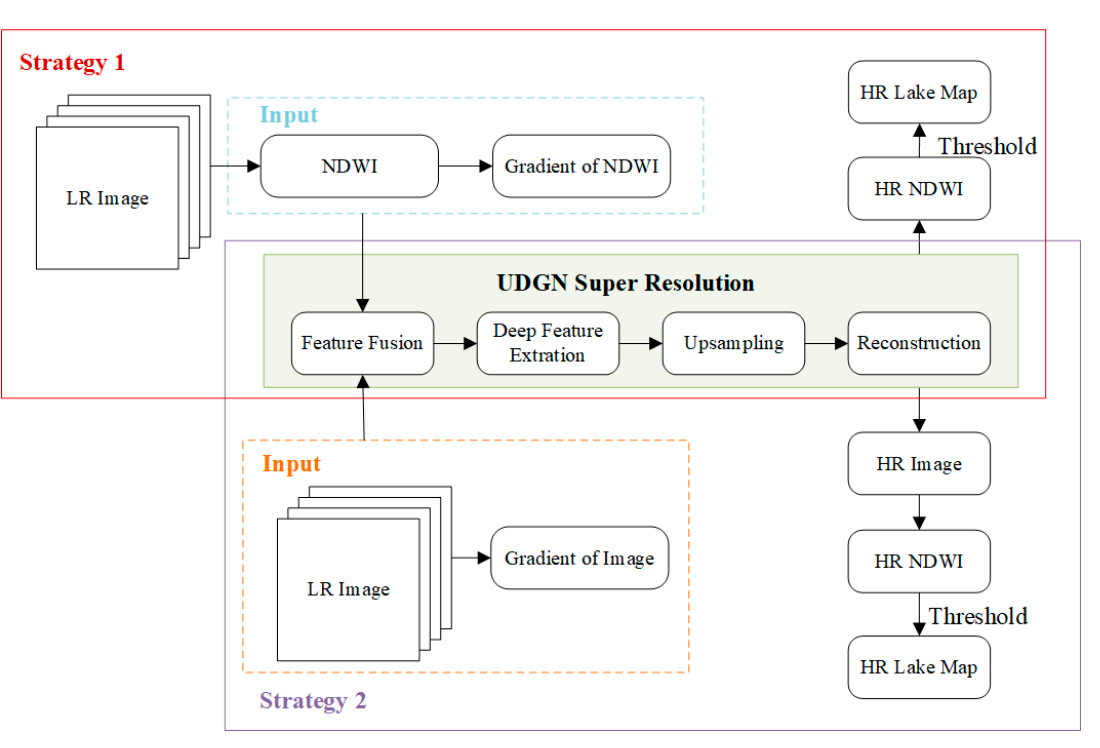
Figure 3. Examples of self-similar patterns inside a RS image. Specifically, the unsupervised learning mechanism is shown in Figure 4. Each test image 𝐼 (cid:3047)(cid:3032)(cid:3046)(cid:3047) is down-sampled first to obtain the lower-resolution image 𝐼 (cid:3013)(cid:3019) . Then, corresponding image patches